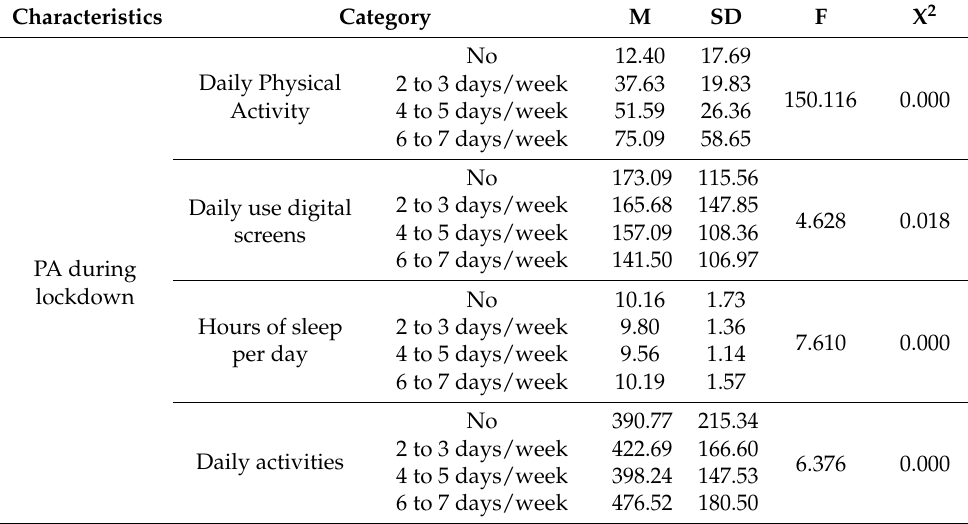
Table 5. Physical activity during lockdown according to children’s healthy, everyday behaviours. Characteristics